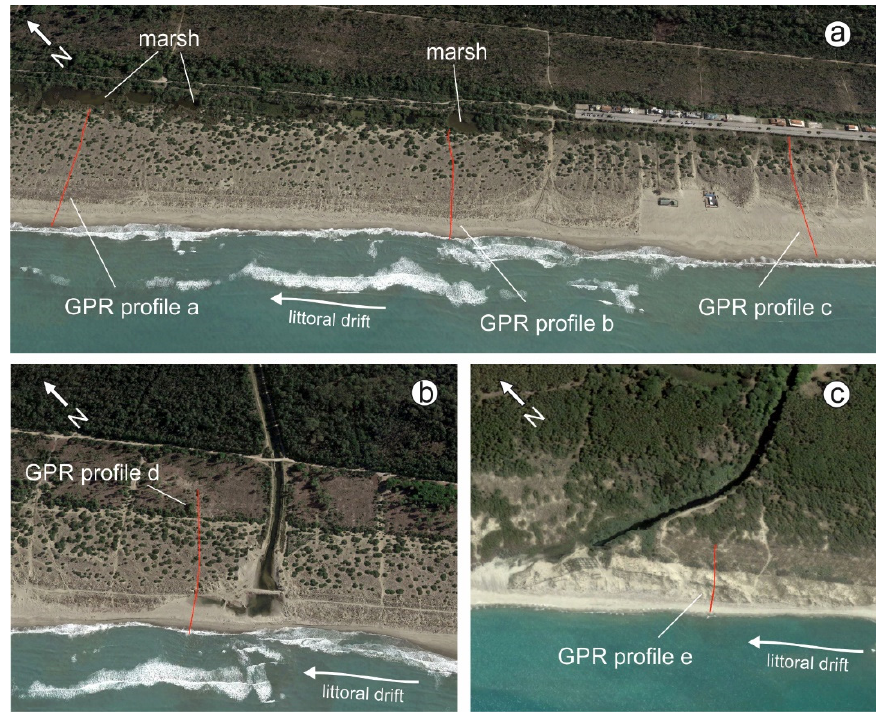
Figure 2. Oblique satellite imagines indicating the positions of the GPR profiles in the northern ( a ), central ( b ) and southern ( c ) sectors. For sectors’ locations in the littoral cell, see Figure 1. Source, Google Earth; acquisition dates, 2019 ( a , b ) and 2014 ( c ).